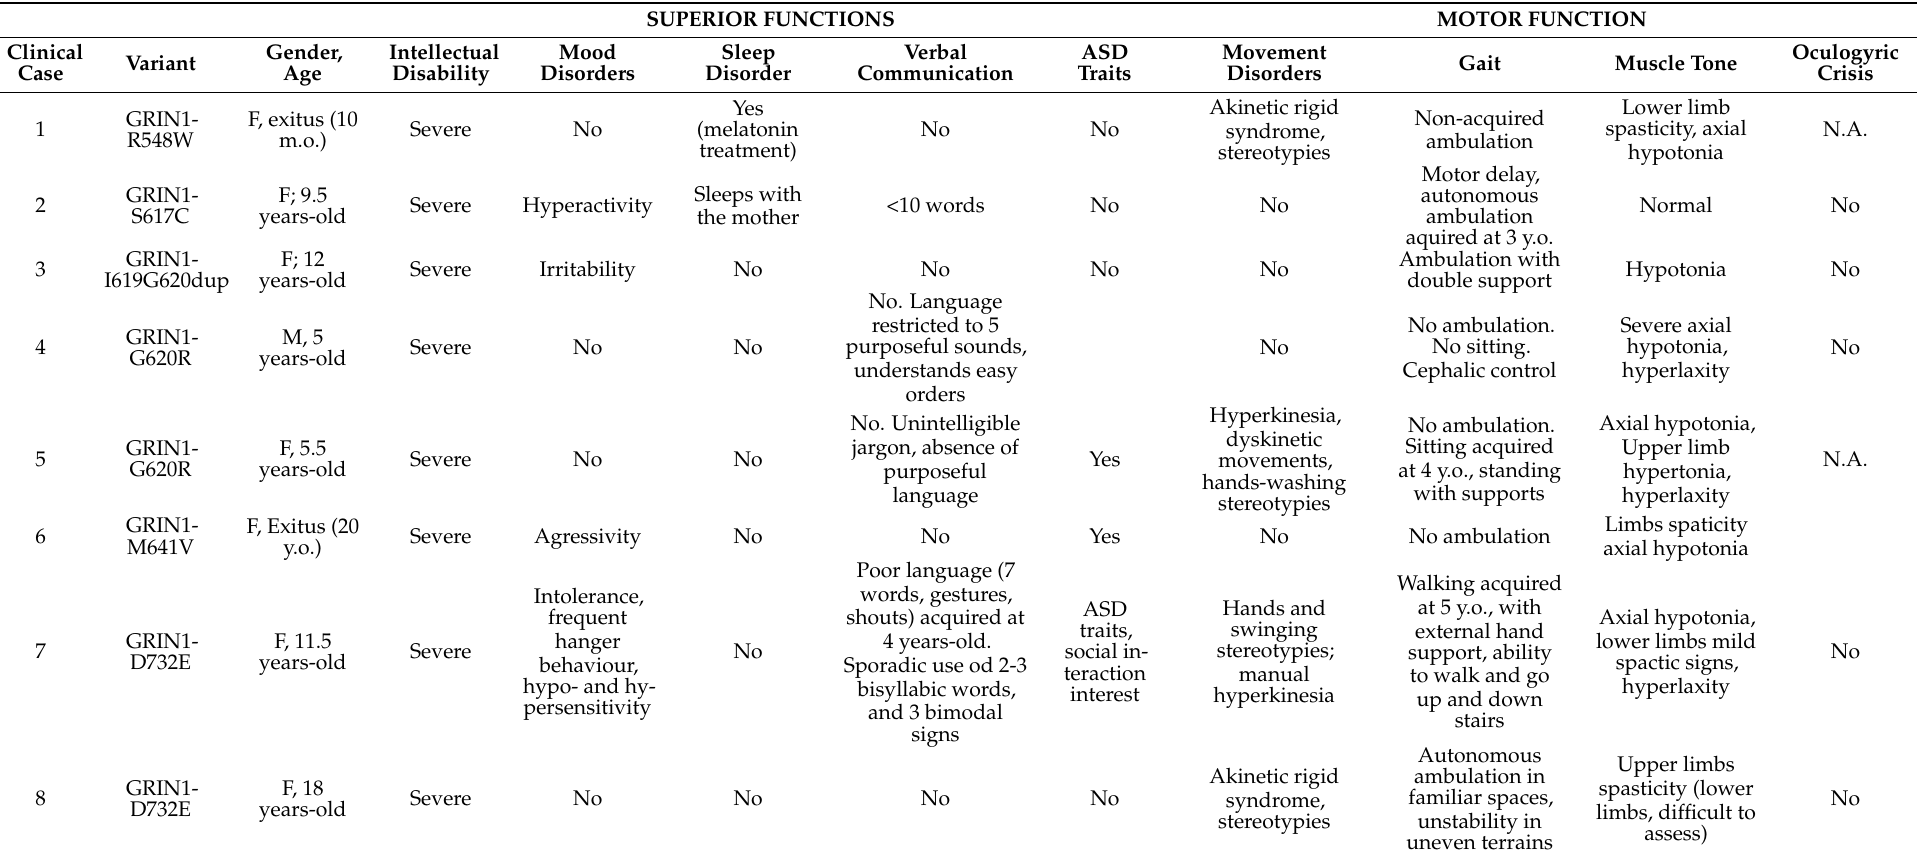
Table 1. Comprehensive clinical assessment of GRIN1 -DNV patients cohort. The table summarises the neurological symptoms associated with the presence of de novo GRIN1 variants harboured by single individuals or, in certain cases ( GRIN1 -G620R, -D732E, -E834Q), in two familiarly unrelated